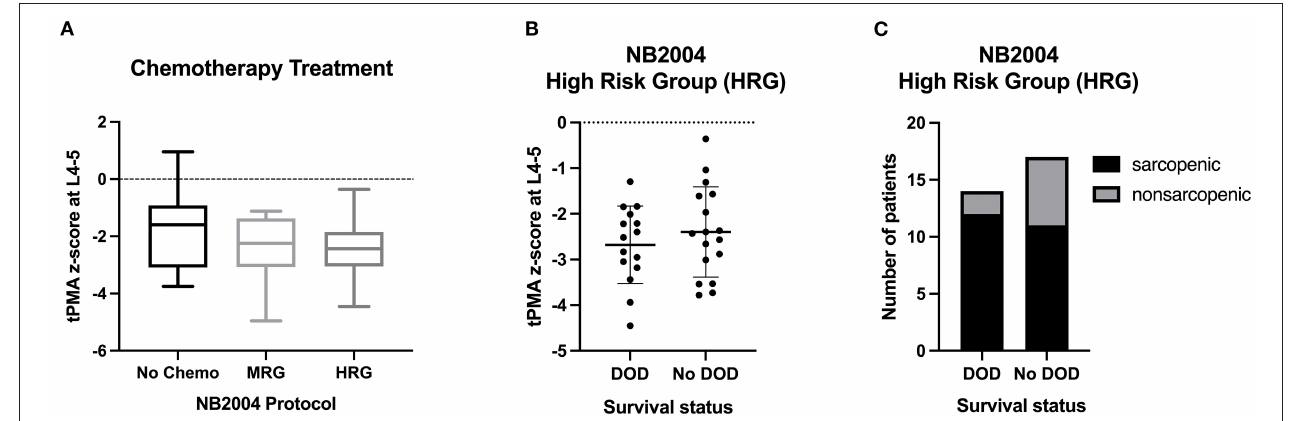
FIGURE 2 | (A) Chemotherapy treatment according to NB2004 protocols. Middle line - median; Interquartile range - box; 25–75% - Whiskers; Tukey Test. (B) Distribution of the tPMA z-score at L4-5 among survival groups within the NB2004 high-risk group. Middle line - mean; Upper and lower lines - SD. (C) Prevalence of sarcopenia among survival groups within the NB2004 high-risk group. Chemo, chemotherapy; MRG, medium risk group; HRG, high-risk group; DOD, death of disease.